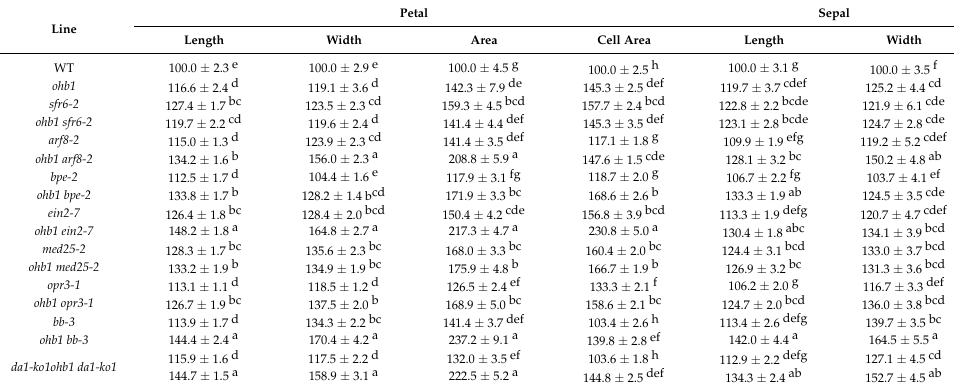
Table 2. Phenotypic characteristics of the flowers produced by the large flower mutants and the double-mutant lines created through a cross with ohb1